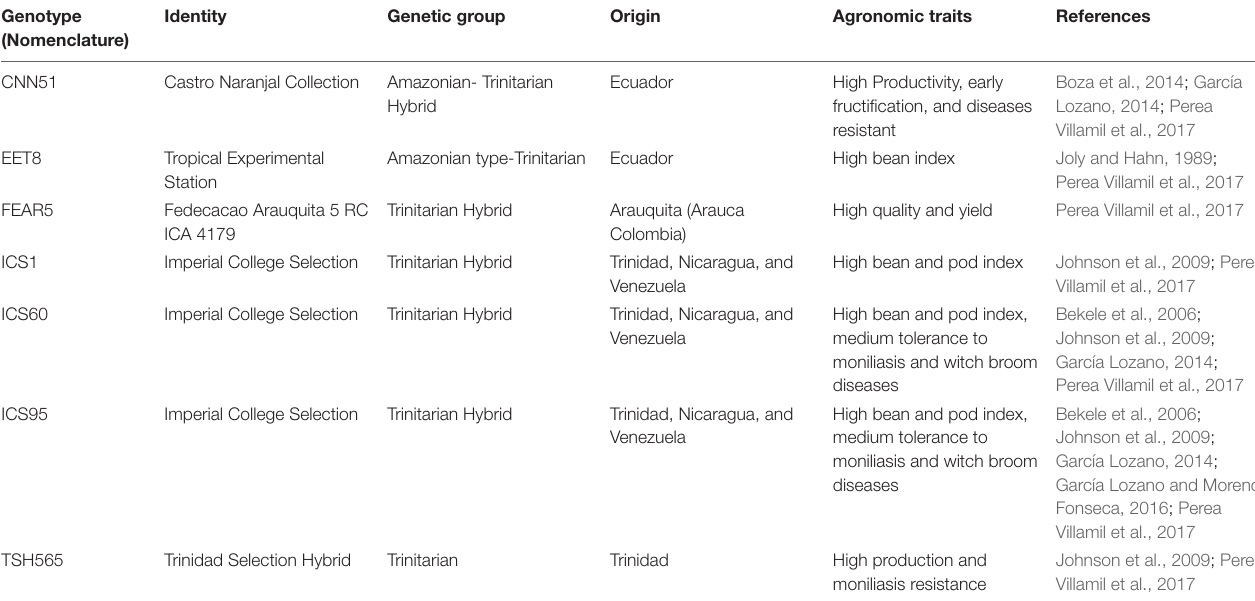
TABLE 1 | Cacao commercial clones used in this